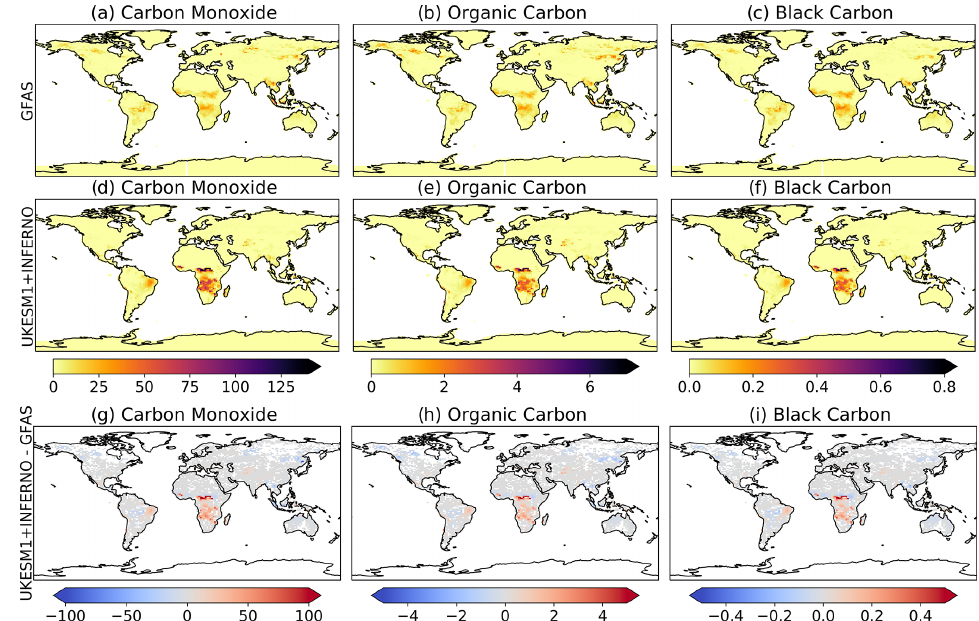
Figure 6. Biomass burning emissions mean annual average (2003–2011) for CO (gm − 2 ) in (a) GFAS, (d) UKESM1+INFERNO and (g) difference between UKESM1+INFERNO and GFEDv4; OC (gm − 2 ) in (b) GFAS, (e) UKESM1+INFERNO and (h) difference between UKESM1+INFERNO and GFEDv4 and BC (gm − 2 ) in (c) GFAS, (f) UKESM1+INFERNO and (i) difference between UKESM1+INFERNO and GFAS. Differences are only shown for statistically significant points with a 95% confidence